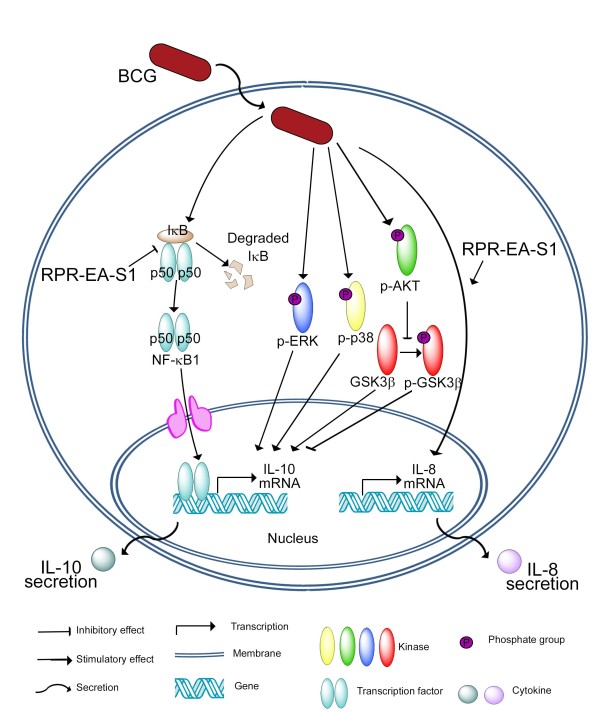
Mechanisms underlying the immunomodulation effects of RPR-EA-S1. In BCG-stimulated macrophages, RPR-EA-S1 can specifically inhibit IL-10 production and yet enhance IL-8 expression. RPR-EA-S1 did not affect the phosphorylation of cellular protein kinases including ERK, p38, Akt and GSK3β. Its inhibitory effects in BCG-activated IL-10 expression may be, at least in part, through the suppression of the degradation of IκBα in the cytoplasm and thus inhibited the translocation of transcription factor NF-κB1 p50 to the nucleus.